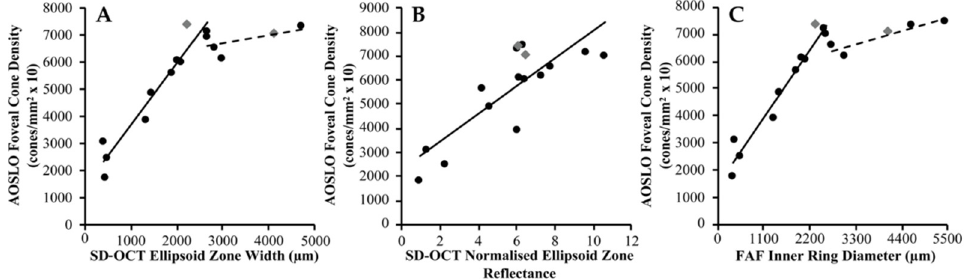
Figure 4. Clinical retinal imaging correlation with photoreceptor density in USH2A retinopathy. Scatterplots of metrics from ( A , B ) spectral-domain optical coherence tomography (SD-OCT) and ( C ) fundus autofluorescence (FAF) imaging in association with foveal cone density in USH2A -associated Usher syndrome (black circles) and non-syndromic retinitis pigmentosa (grey diamonds) are shown. ( A ) SD-OCT ellipsoid zone width ( n = 15) and ( C ) FAF inner ring diameter ( n = 16) demonstrate a biphasic relationship with foveal cone density, whereby reduction to ~2700 µ m is associated with slow cone loss (dashed black line) below which faster decline in cone density occurs (solid black line). ( B ) SD-OCT normalised ellipsoid zone reflectance ( n = 16) displays linear correlation with foveal cone density, with a line of best fit shown (solid black